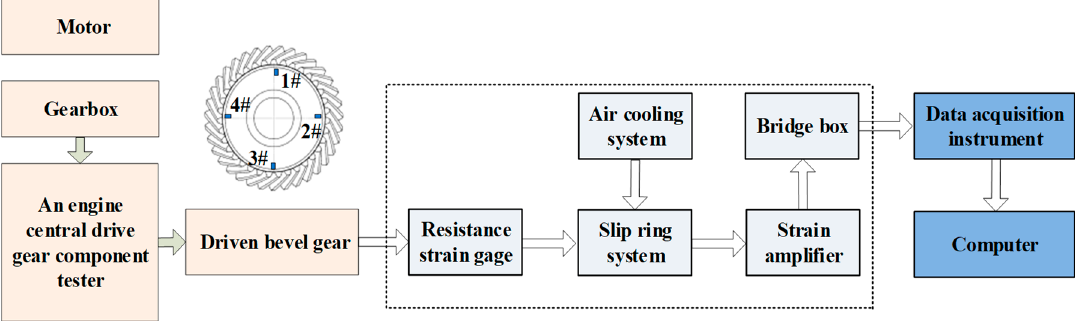
Figure 5. Stress measuring point layout and measurement system.